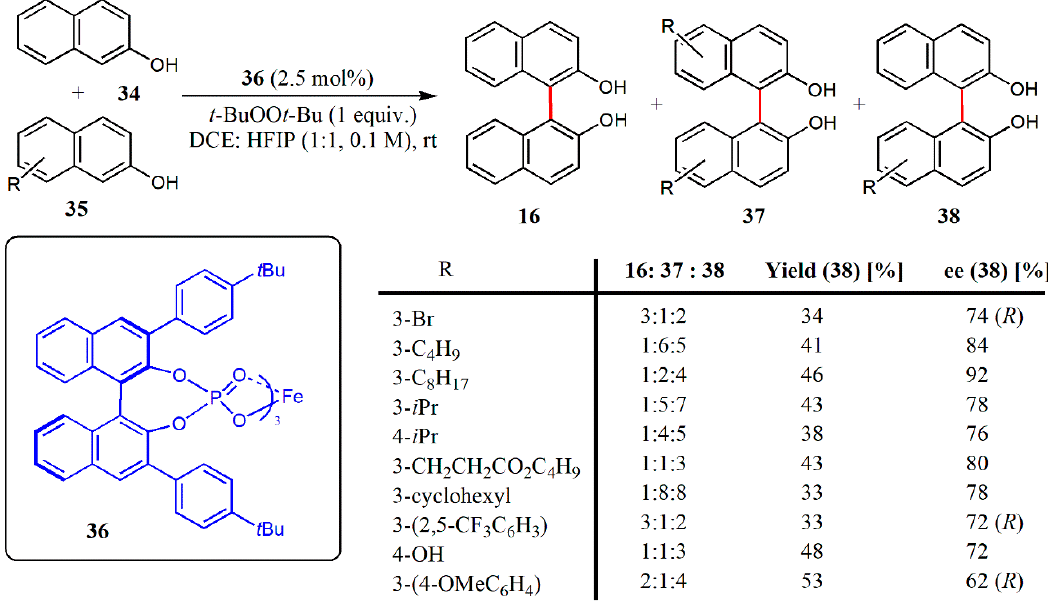
Figure 12. The mechanism proposed for the iron-catalyzed enantioselective CDC of 2-naphthols. Narute and Pappo developed a procedure to couple 2-naphthols with β -ketoesters in 2017 [50]. A racemic version was tried with [FeCl 3 ·6H 2 O] and t -BuOO- t -Bu in 1,2-dichloroethane. Product 40a resulting from the coupling of 2-naphthol 35a (R 1 = H) with α -substituted- β -ketoester 39a , bearing a chiral auxiliary (R 2 = ( − )-menthyl), was obtained as a mixture of diastereoisomers (7a R ,10a S ) and (7a S ,10a R ) in ca. 46:54 ratio (Figure 13). Several BINOL derivatives were subsequently tested in the search for a suitable chiral anion for asymmetric induction. When the reaction was performed under the same conditions as those shown in Figure 11, at rt, only homocoupled product was obtained, i.e., enantio-enriched ( R )-BINOL. However, at high temperatures, high regioselectivity and